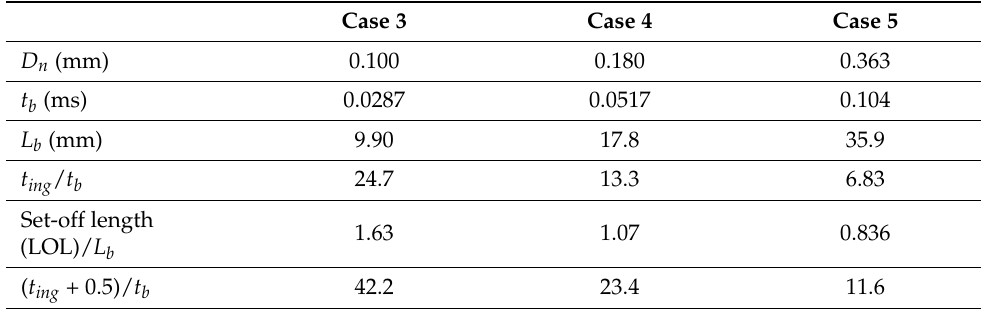
Table 8. Spray characteristics based on breakup scaling.